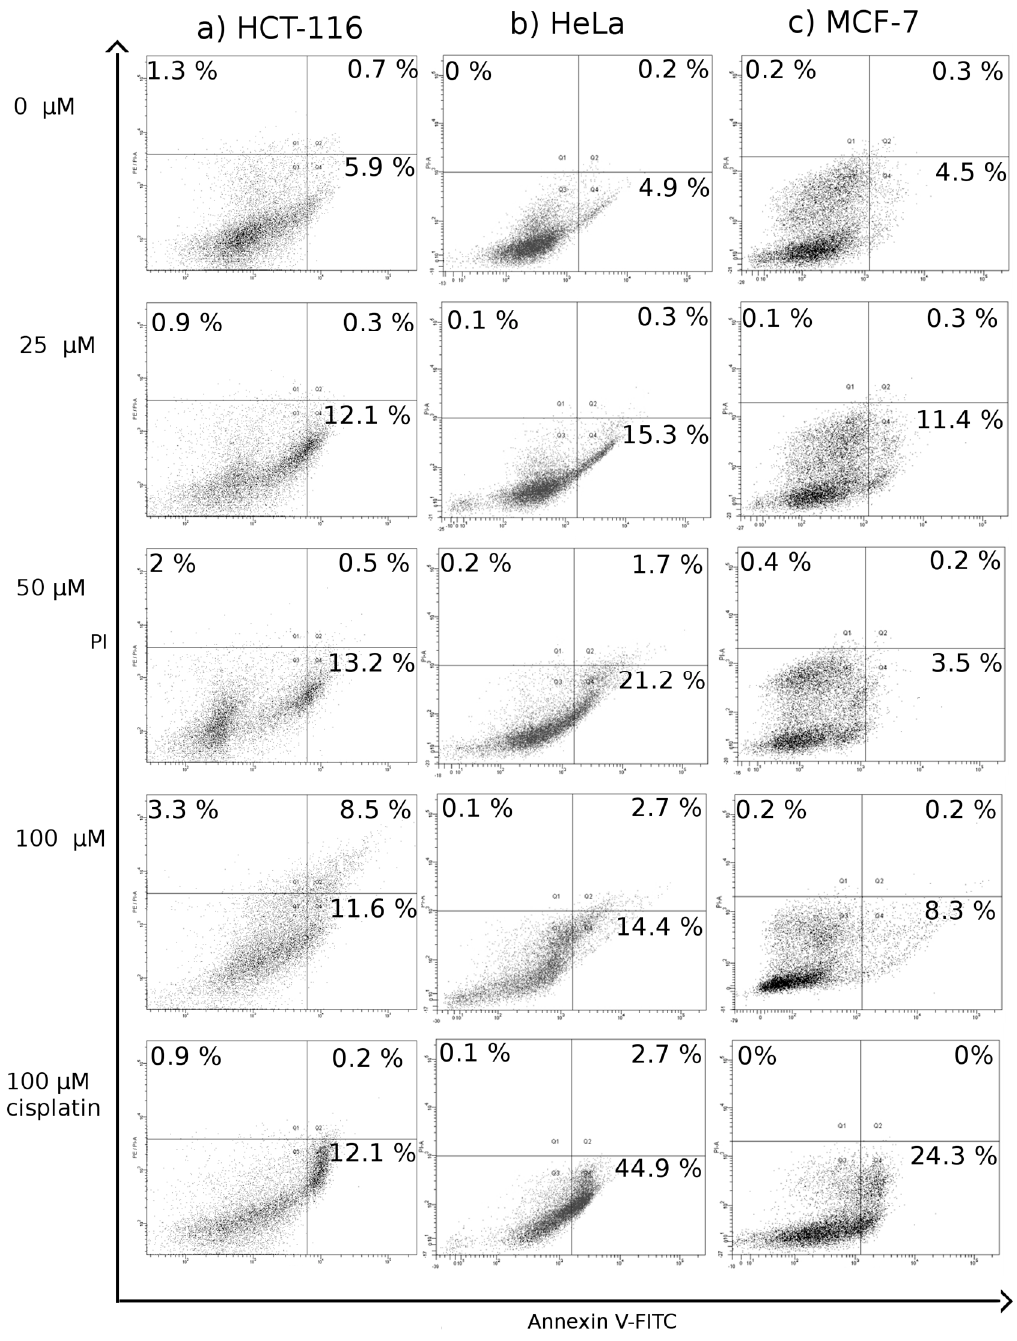
Figure 6. Features of dying process of HCT-116 ( a ); HeLa ( b ) and MCF-7 ( c ) cell lines (representative results). Dotblots show cells stained with Annexin V-FITC Apoptosis Kit. HCT-116, HeLa cells treated with 37 (0–100 µ M) and cisplatin (100 µ M); MCF-7 cells treated with 46 (0–100 µ M) and cisplatin (100 µ M) for 24 h. Results show the mean of number of cells in each quadrant Q1, Q2, Q3, Q4 (necrotic cells, late apoptotic cells, alive cells, apoptotic cells, respectively).